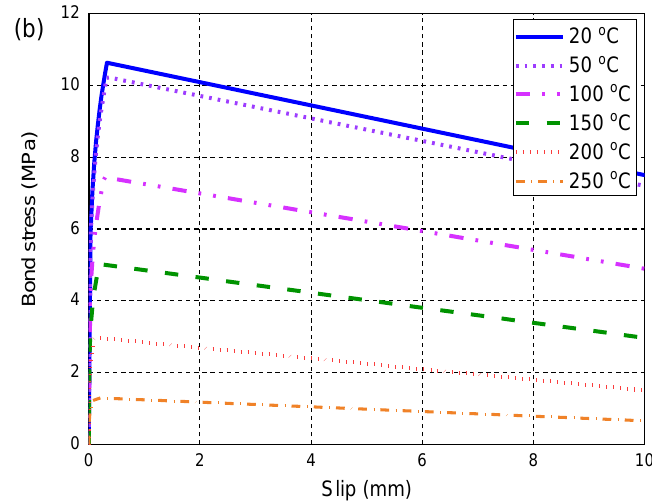
Figure 4. Local bond–slip model used in the FE model: ( a ) Slab GA; ( b ) Slabs S1, S2, and S3.